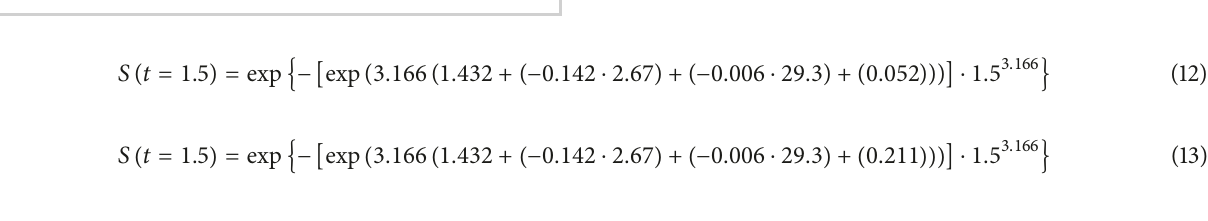
Figure 3: Survival curves of